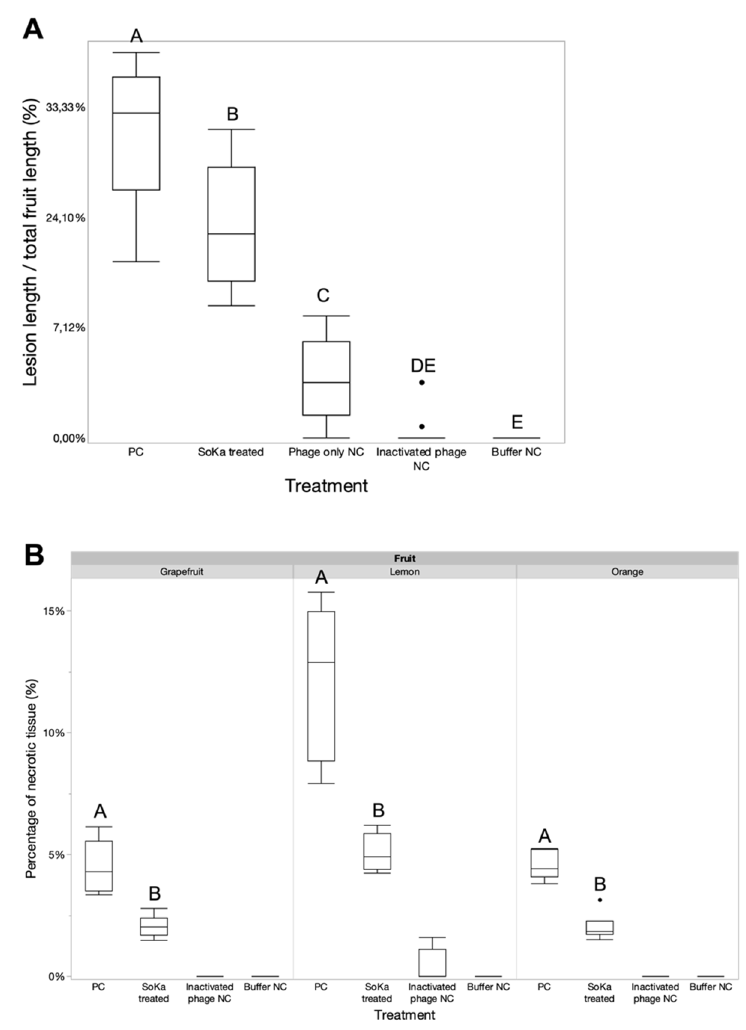
Figure 6. Fruit bioassays to test the efficacy of phage treatment on symptom reduction. ( A ) First phage bioassay on lemon fruits. The lengths of the bacterial lesions induced by strain KB49 were measured and plotted compared to the total length of the fruit. Injection of the SoKa phage significantly reduced the average lesion length compared to control fruits (Wilcoxon test). ( B ) The same bioassay setup was repeated on grapefruit, orange, and lemon fruits. Here, the necrotic tissue of the treated samples were compared with the untreated group (Wilcoxon test for orange, Student’s t -test for grapefruit, Games–Howell test for lemon). Significant differences between the different treatment groups (separately for each fruit) are indicated with a different letter ( p < 0.05). PC = positive bacteria-only control; NC = negative